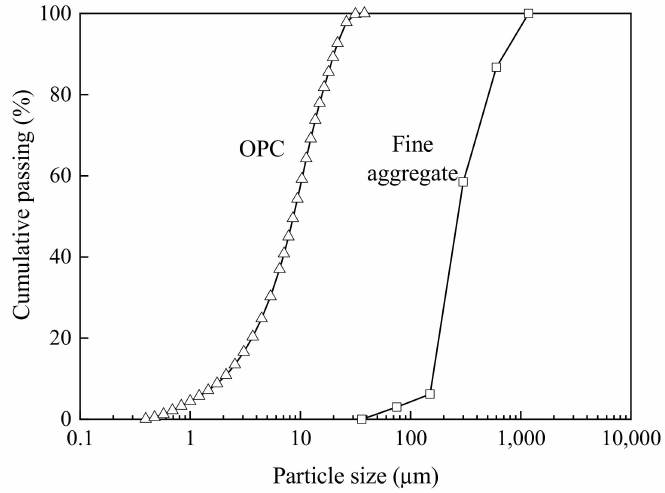
Figure 2. Particle size distributions of OPC and